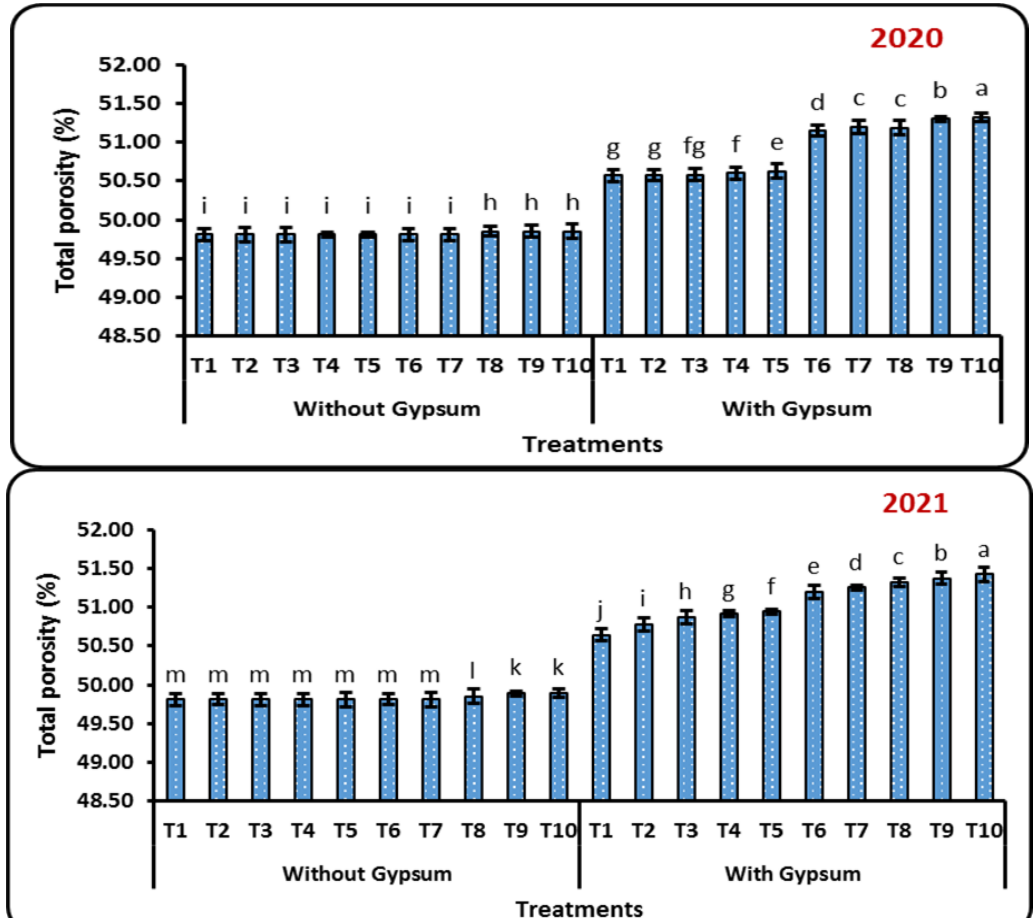
Figure 1. Combined effects of gypsum and bio-priming with PGPR and different levels of chitosan (0, 25, 50, 75, and 100 mg L − 1 ), on soil physical characteristics at 120 days from sowing during 2020 and 2021 seasons. BD : bulk density ; T1 – T10: as shown in Table 3. According to the Duncan’s test, means denoted by various letters show significant differences between treatments ( p ≤ 0.05).